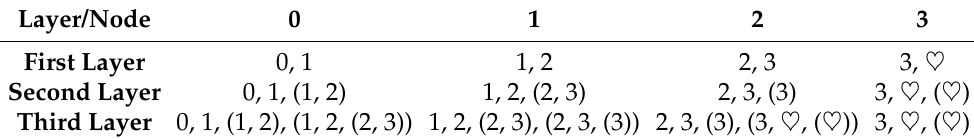
Table 1. An Example: Information for each node in per